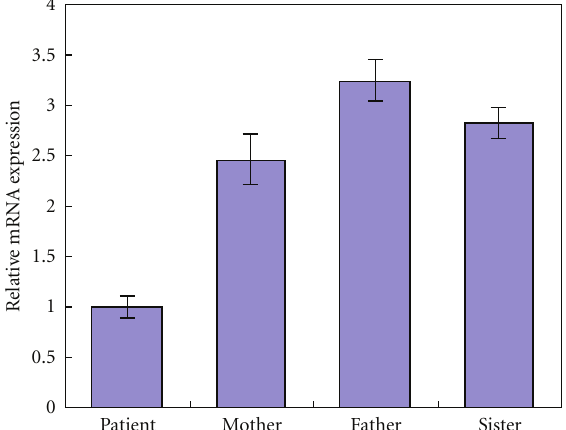
Figure 3: Relative STAT3 mRNA expression levels in the